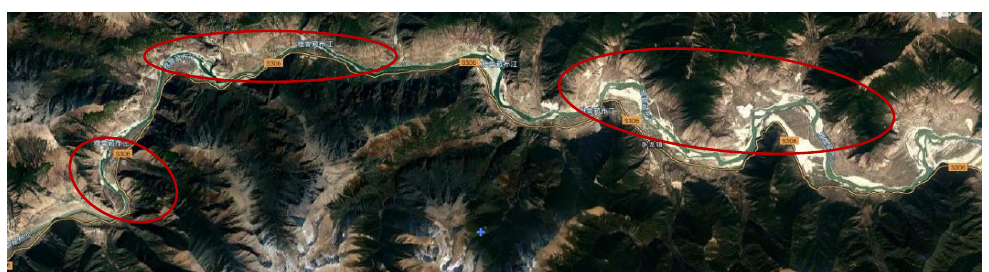
Figure 8 . "n" shape watershed.